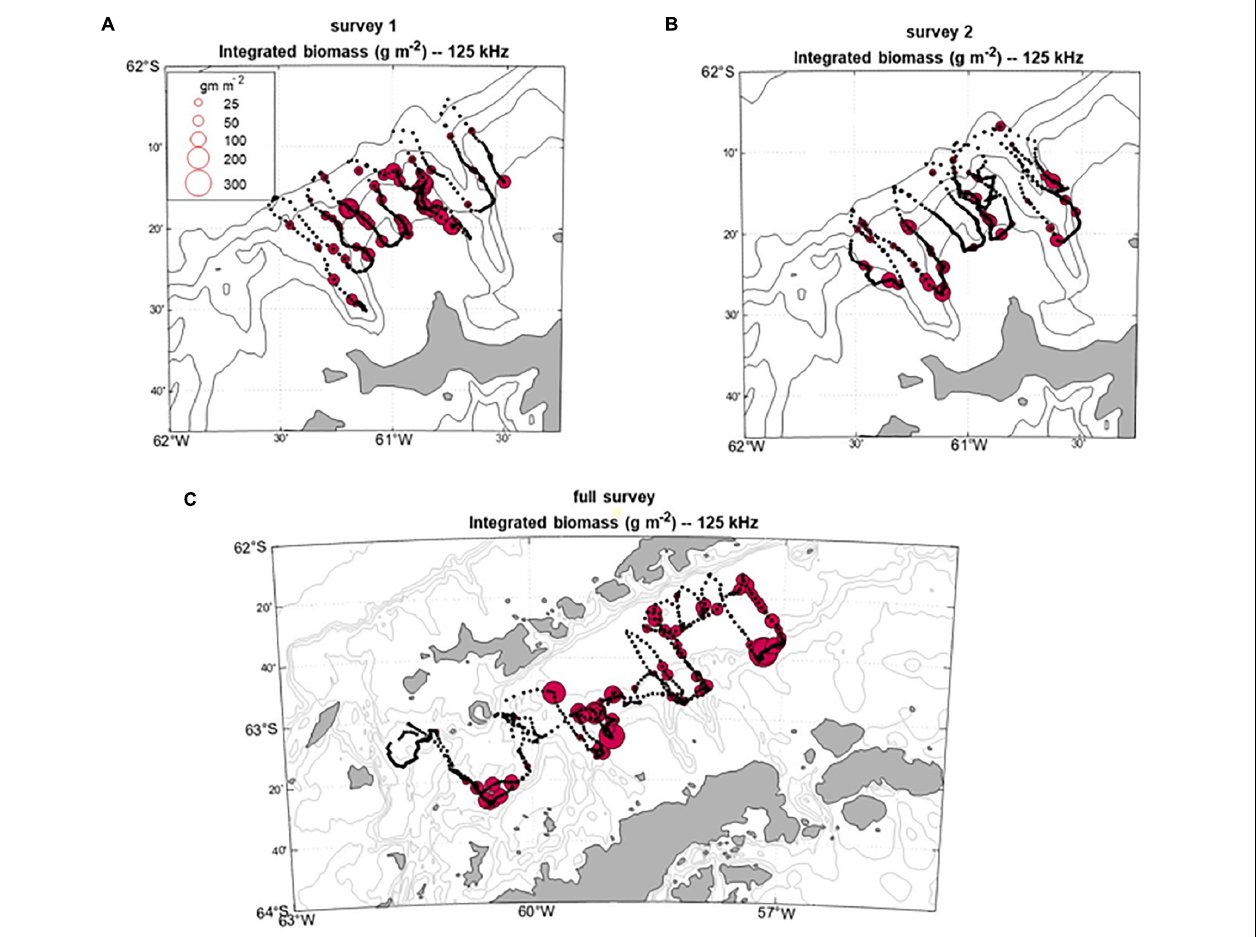
FIGURE 5 | The spatial distribution of krill biomass density (g m − 2 ) at 125 kHz. Bubbles represent dives converted to profiles (as in Figure 2 ) and integrated over 5–250 m. The distances between points are a function of dive depth (deeper dives are farther apart) and whether each vehicle’s forward progress was hampered or enhanced by currents. The top two panels illustrate results from the two small-scale surveys flown over the West Shelf off Cape Shirreff from (A) mid-December 2018 to mid-January 2019 and (B) mid-January 2019 to mid-February 2019 (B) . (C) Biomass density in Bransfield Strait from mid-December 2018 to mid-January 2019. Bathymetric contours are 150, 1000, and 3000